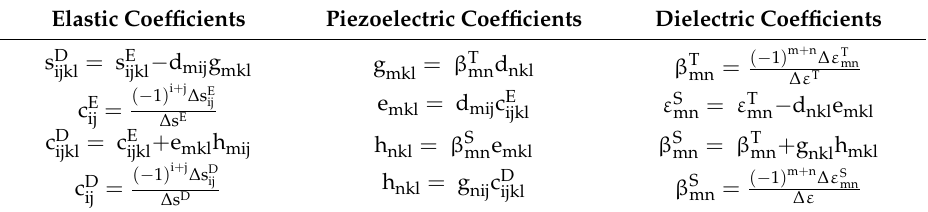
Table 2. Relations between the electric, piezoelectric, and mechanic tensors. Elastic Coefficients